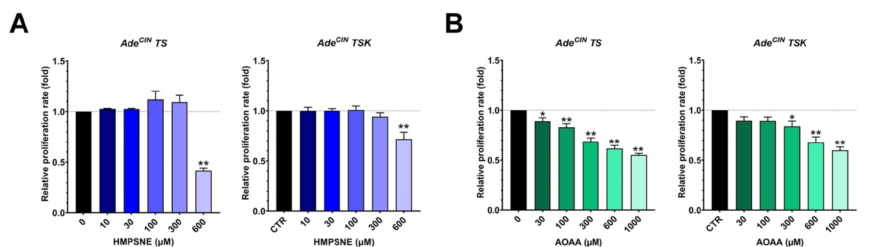
Figure 5. Pharmacological inhibition of H 2 S biosynthesis in Ade CIN TS and Ade CIN TSK attenu- ates cell proliferation. ( A ) Relative proliferation rate of Ade CIN TS and Ade CIN TSK in the presence of increasing concentrations of HMPSNE for 48 h. ( B ) Relative proliferation rate of Ade CIN TS and Ade CIN TSK in the presence of increasing concentrations of AOAA for 48 h. Data represent mean ± SEM of at least 4 independent experiments. * p < 0.05, ** p < 0.01 compared to control.